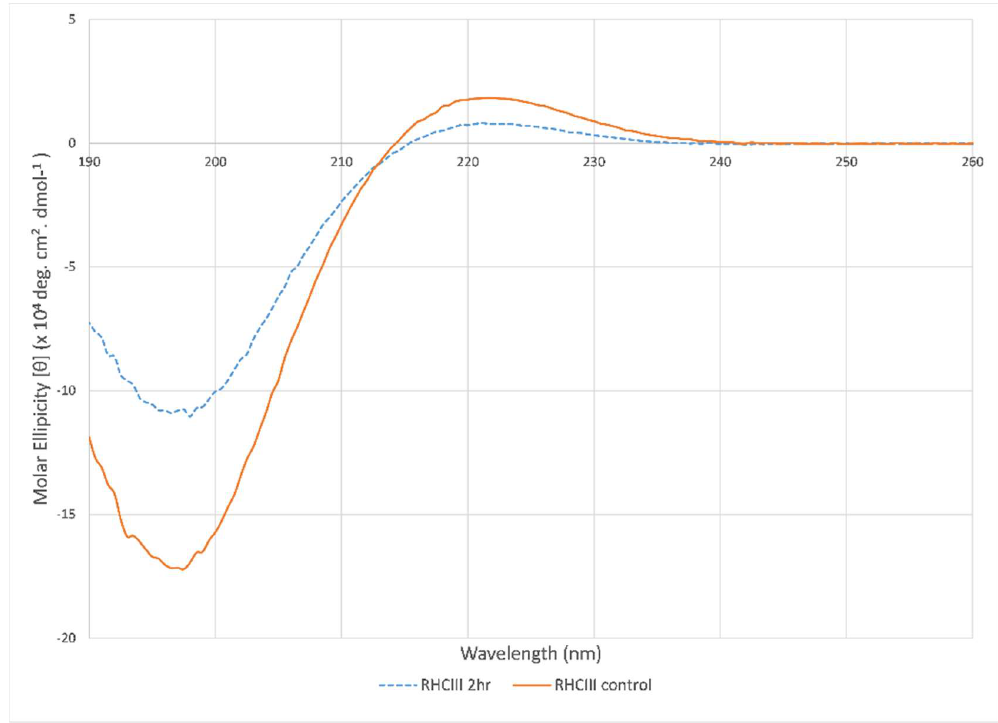
Figure 6. CD spectra of untreated RHCIII and 2-h sonicated RHCIII showing the characteristic collagen CD ellipticity with a positive peak centered on 221 nm and a negative peak centered on 197 nm.